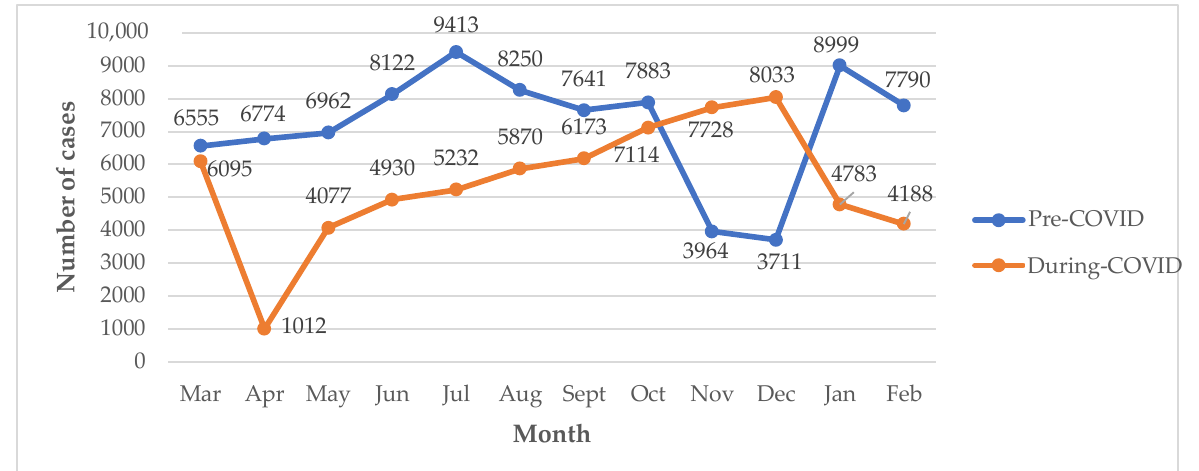
Figure 1. Trend of the total number of recorded cases at the hospital pre-COVID-19 and during